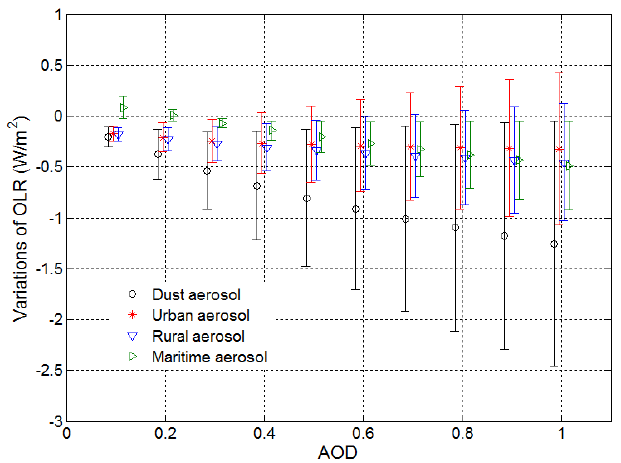
Figure 3. The variations of outgoing longwave radiation (OLR) at different aerosol conditions as the AOD increase. The symbols indicate the variations of OLR and the half-length of vertical bars represent the Standard Deviations of the OLR.